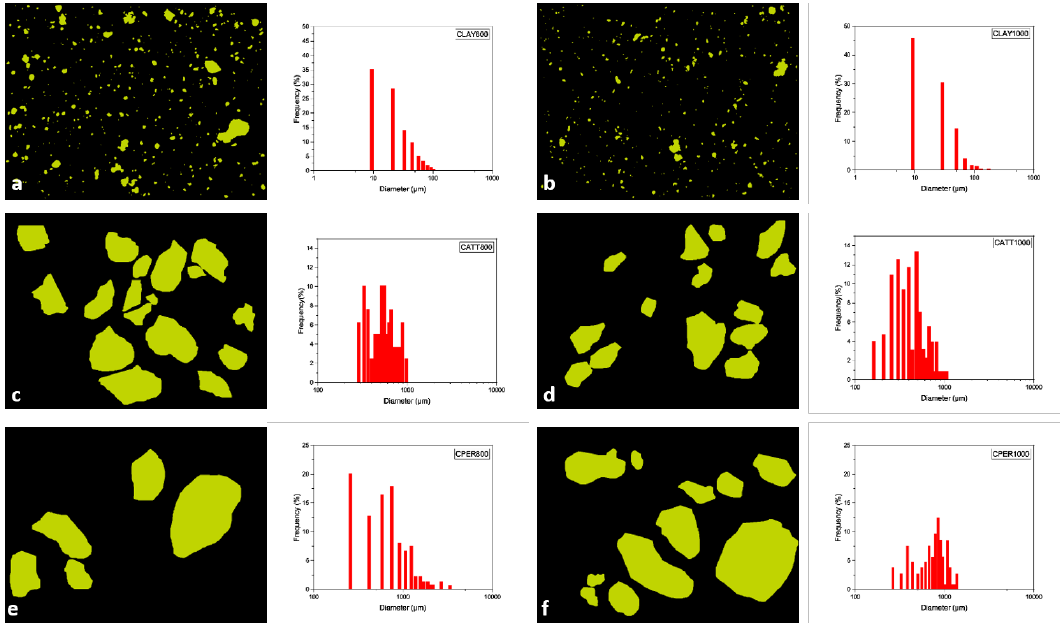
Figure 3. Examples of structures identification and quantification by the software Quantikov. ( a ) Clay fired at 800 °C, ( b ) clay fired at 1000 °C, ( c ) clay with attapulgite fired at 800 °C, ( d ) clay with attapulgite fired at 1000 °C, ( e ) clay with perlite fired at 800 °C, ( f ) clay with perlite fired at 1000